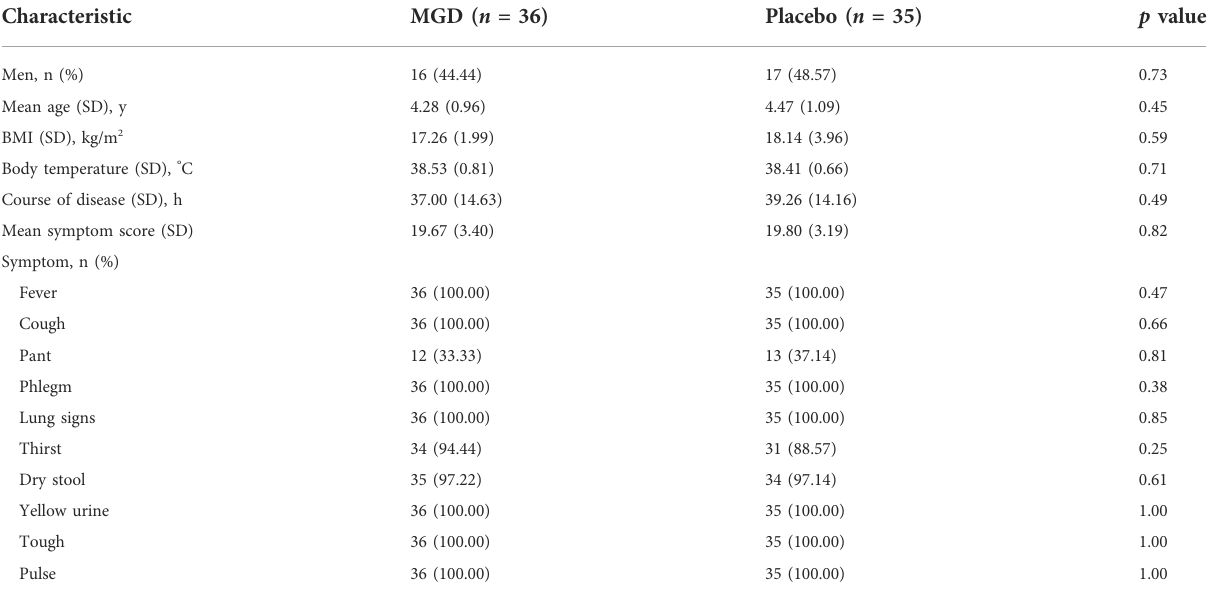
TABLE 2 Demographics and baseline characteristics of